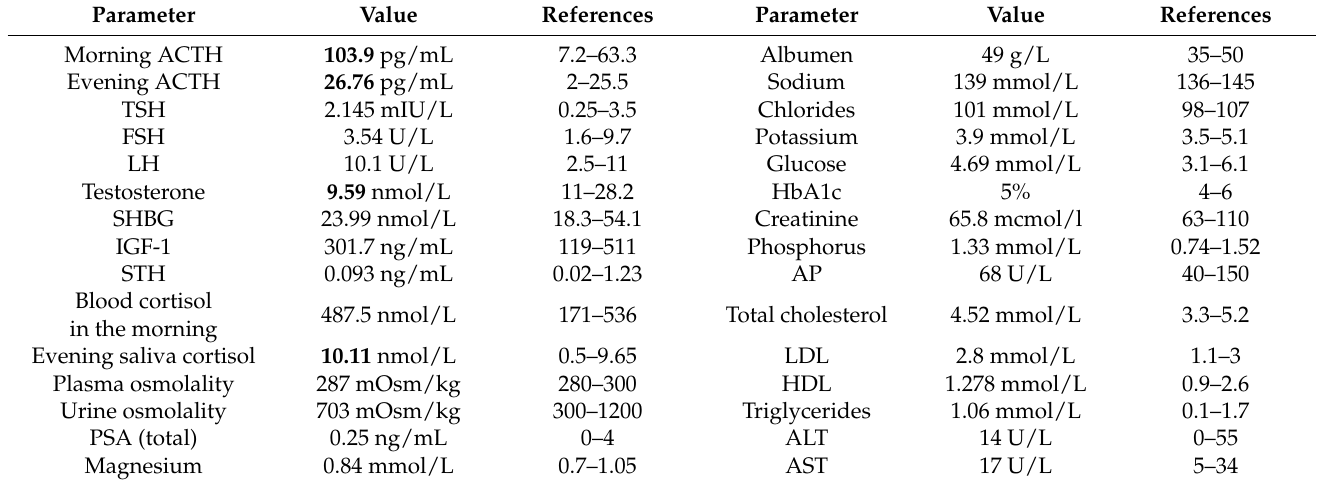
Table 2. Laboratory test results. ACTH—adrenocorticotropic hormone, TSH—thyroid